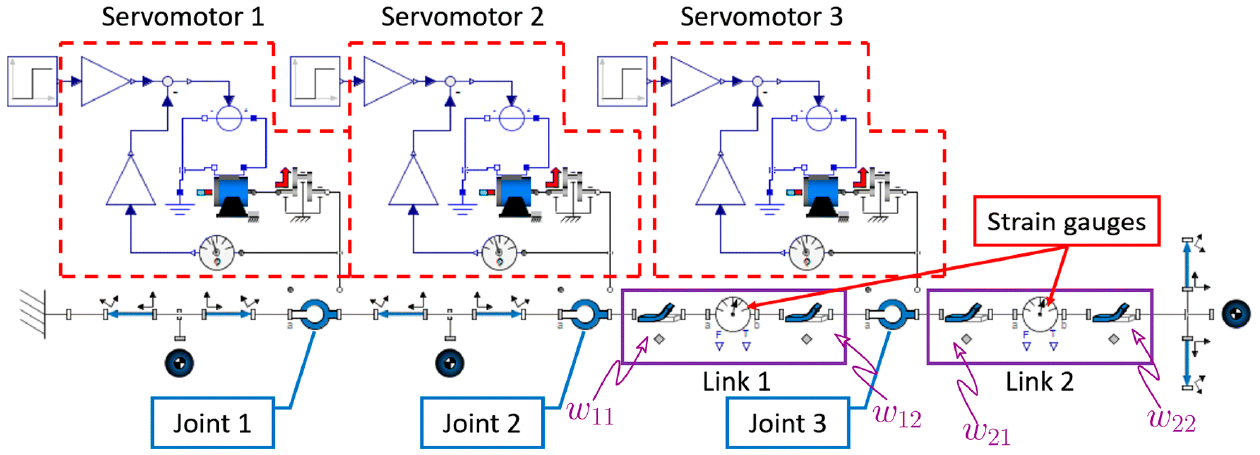
Figure 3. Maplesim model of the manipulator.